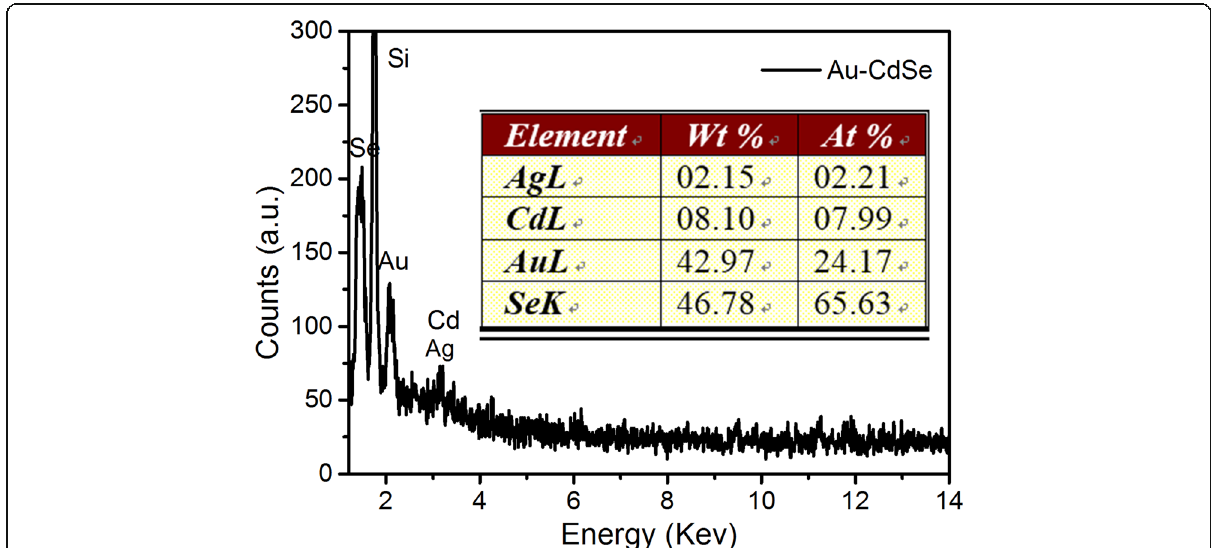
Fig. 4 EDX spectrum of Au/CdSe Janus nanospheres dropped on a silicon wafer. The inset table is the percentage of each element